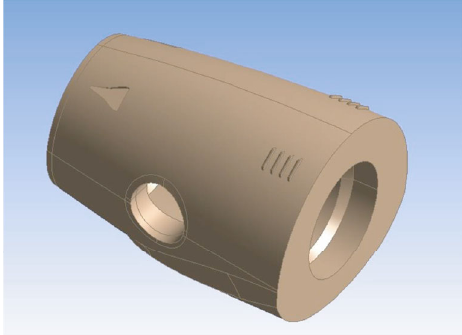
Figure 1: 3D model of the volume between engine and nacelle.